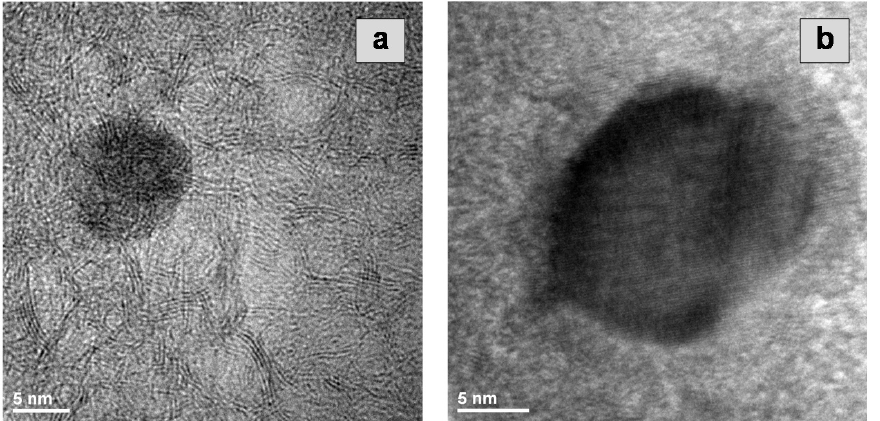
Figure 4. HRTEM images of a single Co particle: ( a ) entirely oxidized—Ba-Co4.9/C catalyst, ( b ) surrounded by an oxide layer—“core-shell” structure of Ba-Co28.2/C catalyst (the spent catalysts after exposure to air—ex situ measurements).